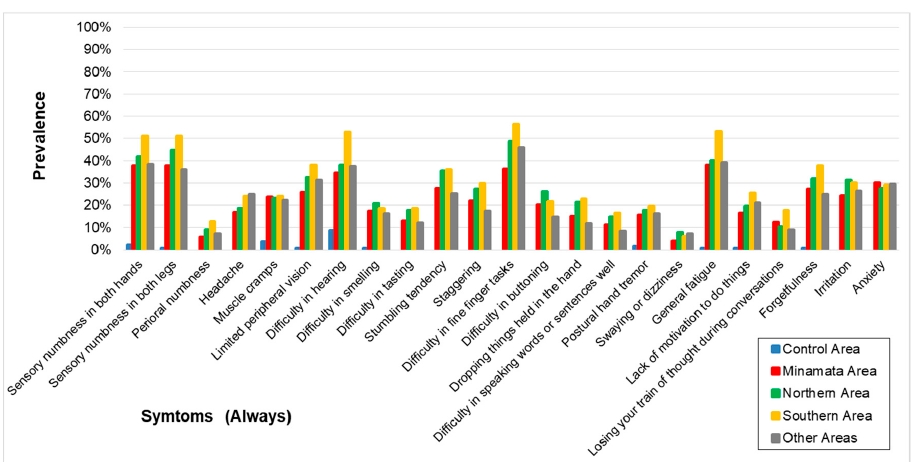
Figure 2. Prevalence of symptoms (Always) in each area. Prevalence was higher in the four exposed groups than that in the control area. The symptomatic patterns were similar among the four groups. Table 4. Correlation of prevalence of symptoms (Always) among each area.